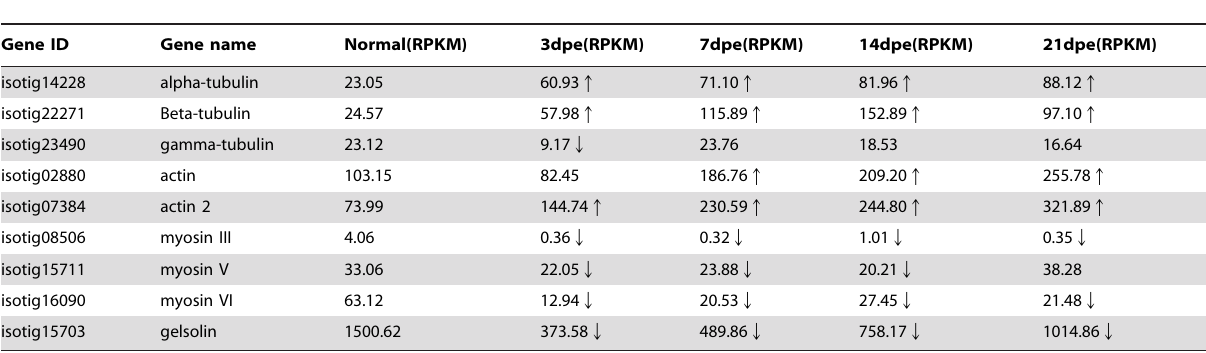
Table 12. Expression profile of Cytoskeletal genes during intestine regeneration.